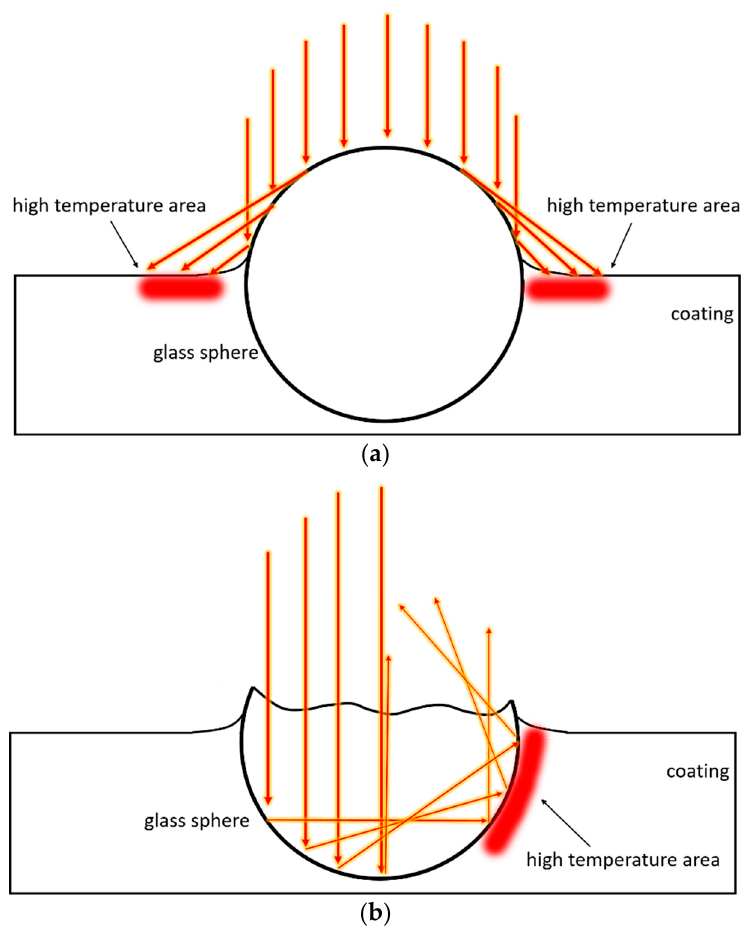
Figure 14. Scheme of local superheating processes, with ( a ) intact sphere and ( b ) broken sphere. Otherwise, at the end of the degradation test (cycle 6), the microspheres C40 and C15 lead to a reduction of Tsurf equal to about 3.5 ◦ C and 3.0 ◦ C, respectively, compared